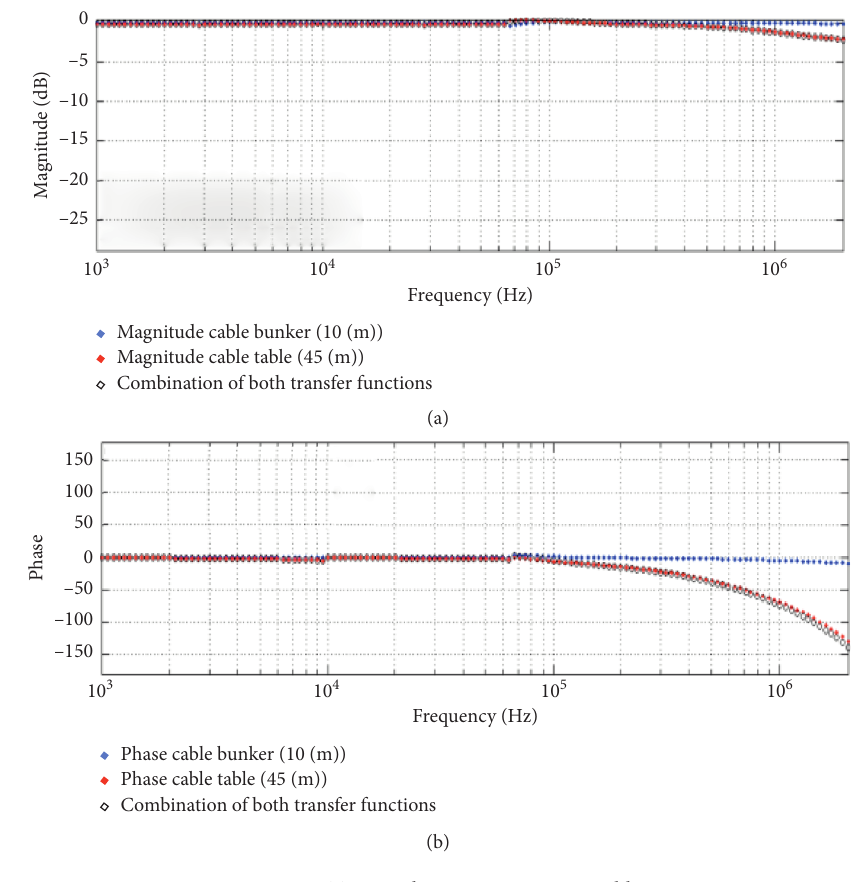
Figure 16: Test on the instrumentation cables.